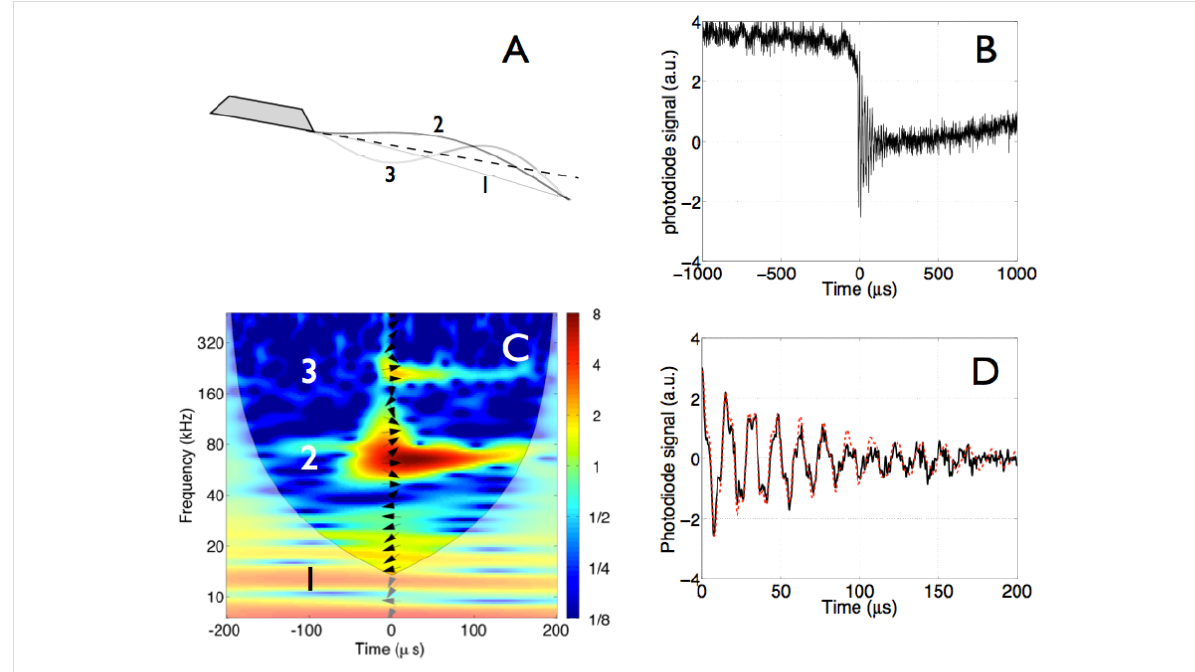
Figure 1: Synthesis of the wavelet retrieval method. (A) Schematic diagram of the modal shapes of the cantilever flexural modes. (B) The time evolu- tion of the relaxation oscillations after the cantilever jump-to-contact transition. (C) The wavelet analysis of the relaxation oscillations. The numbers refer to the excited flexural modes of the cantilever, schematized in (A). Note that the fundamental mode does not oscillate because after the lever remains statically bent after the jump-to-contact. The slope of the arrows arranged in a vertical row superposed on the wavelet spectra measures the local phase difference between the signal and the reference sinc function at time zero. The phase difference has been calculated through wavelet cross-correlation, as explained in the text. Arrow pointing right: 0°; up: 90°; left: 180°; down: − 90°. The areas, in which edge artifacts may distort the picture, are delimited by a lighter shade. (D) A reconstruction (red-dotted line) of the relaxation oscillations (continuous black line) obtained by the superposition of damped harmonic oscillators as detailed in the text. This figure is based on adapted versions of Figures 5a, 6, and the inset of Figure 2 in